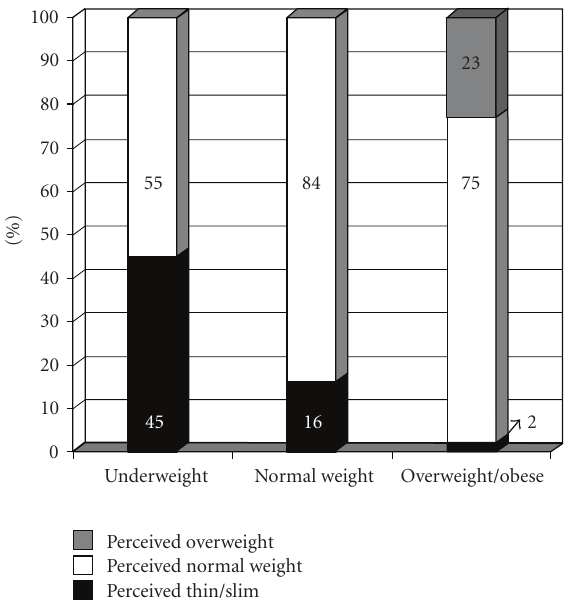
Figure 1: Parental perception of the body weight status of their child per measured body weight